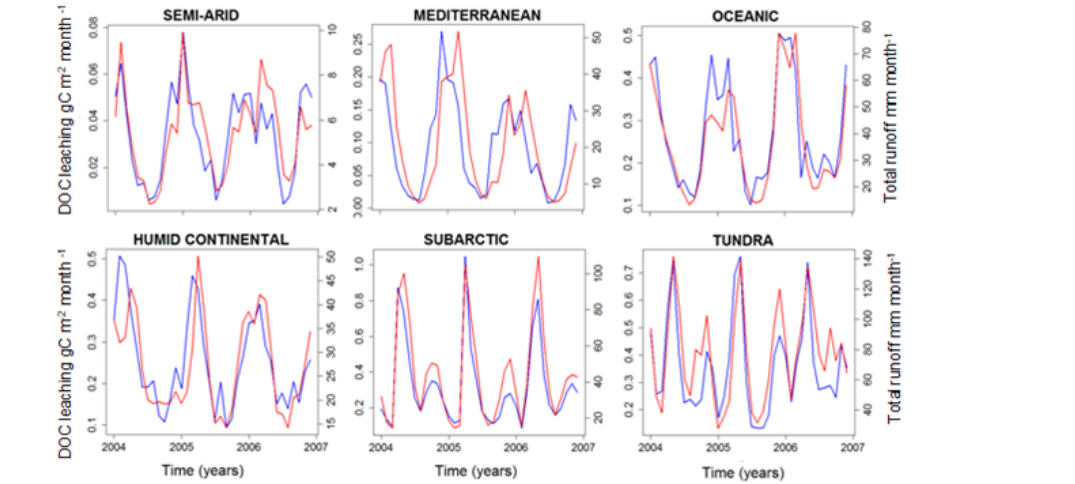
Figure 12. Simulated DOC leaching flux (gCm − 2 per month; blue) and total runoff (mm per month; red) for the six largest climate zones in Europe (period 2004–2006).